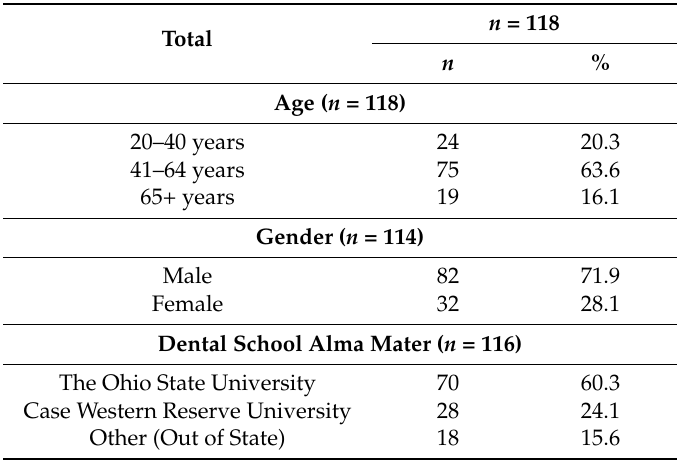
Table 1. Demographics of the study sample.